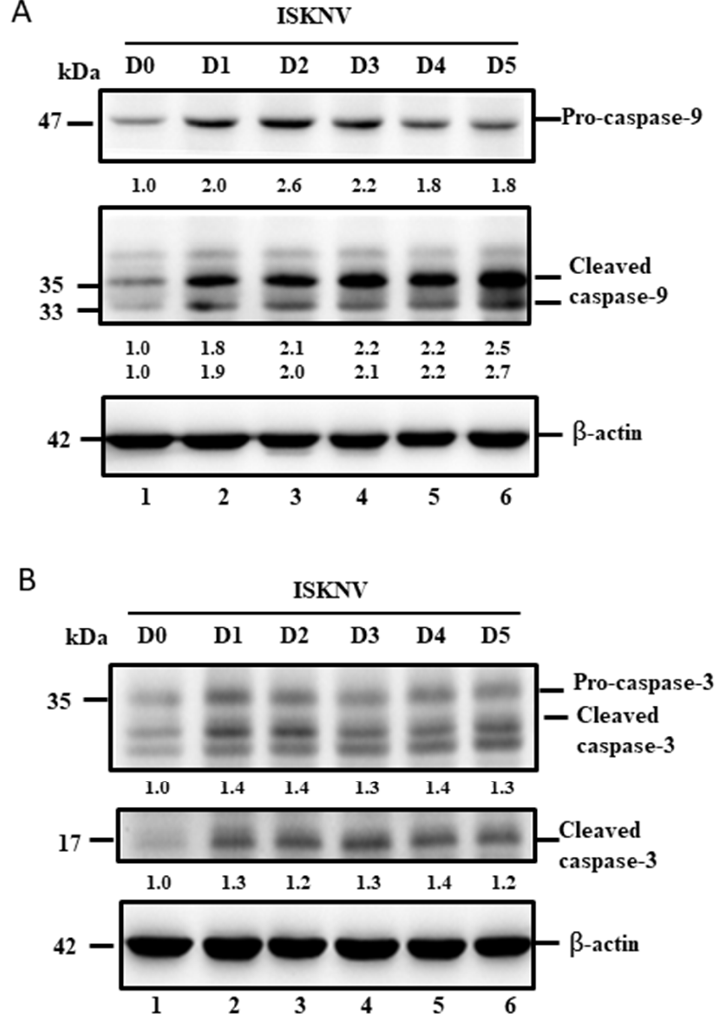
Figure 6. ISKNV infection can activate caspases-9 and -3 in GF-1 cells. ( A , B ). Infection of GF-1 cells with ISKNV at D0, D1, D2, D3, D4, and D5 pi in GF-1 cells that showed ISKNV-induced caspase-9 ( A ) and caspase-3 cleavage ( B ) from procaspase-9 and procaspase-3, as determined by Western blot analyses. Lanes 1-6 correspond to ISKNV-infected GF-1 cells at D0, D1, D2, D3, D4, and D5 pt. Blots were probed with an anti-mouse caspase-9 and caspase-3 monoclonal antibody (1:7500) and an anti-mouse β -actin monoclonal antibody (1:12,500). Quantification of protein expression levels by Image J software, from ( A , B ) that D0 as a one fold control was counted for compared with other ISKNV-infected groups from D1 to D5, respectively.